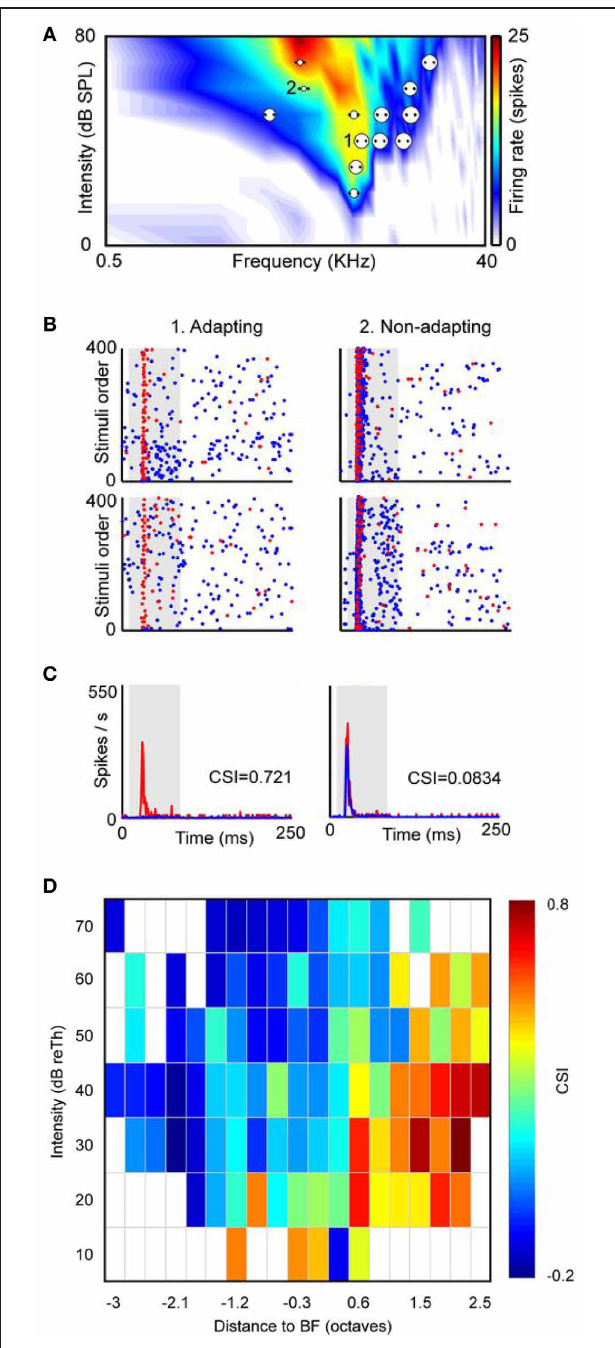
FIGURE 3 | SSA is not homogeneously distributed within the frequency response area of IC neurons. (A) Example of a neuron with a broad V-shaped response area and the distribution of the several pairs of frequencies presented under the oddball paradigm (dots). Each pair of dots is associated to a circle the size of which is proportional to the level of CSI evoked. An example of an adapting pair of frequencies (i.e., frequencies that elicited SSA) is marked as 1 and another example of a non-specifically adapting pair of frequencies is marked as 2. (B) Dot raster plots obtained with the adapting pair (left panels) and with the non-specifically adapting (right panels) pair of frequencies. The blue dots represent spikes evoked